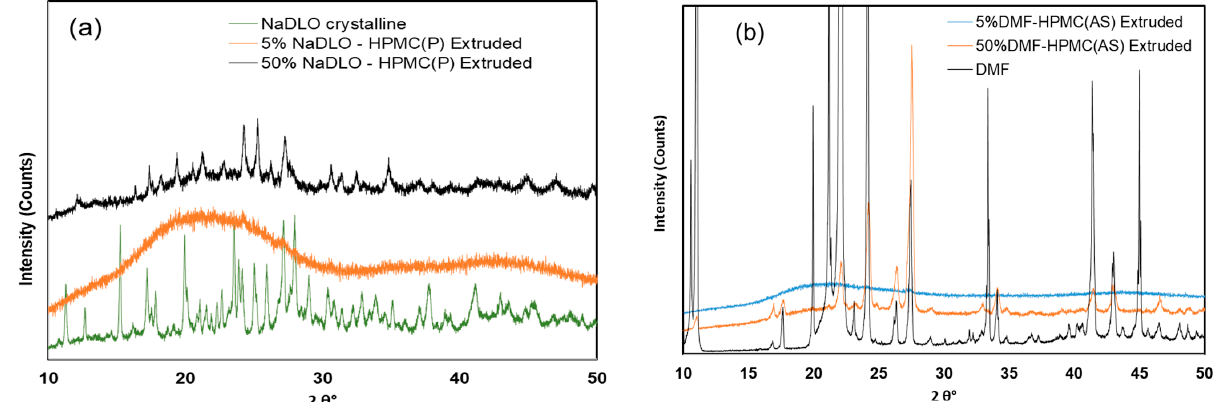
Figure 7. PXRD pa tt ern of ( a ) NaDLO–HPMC(P) extruded, ( b ) DMF–HPMC(AS) extruded at 5% Figure 7. PXRD pattern of ( a ) NaDLO–HPMC(P) extruded, ( b ) DMF–HPMC(AS) extruded at 5% and and 50% API loading. 50% API